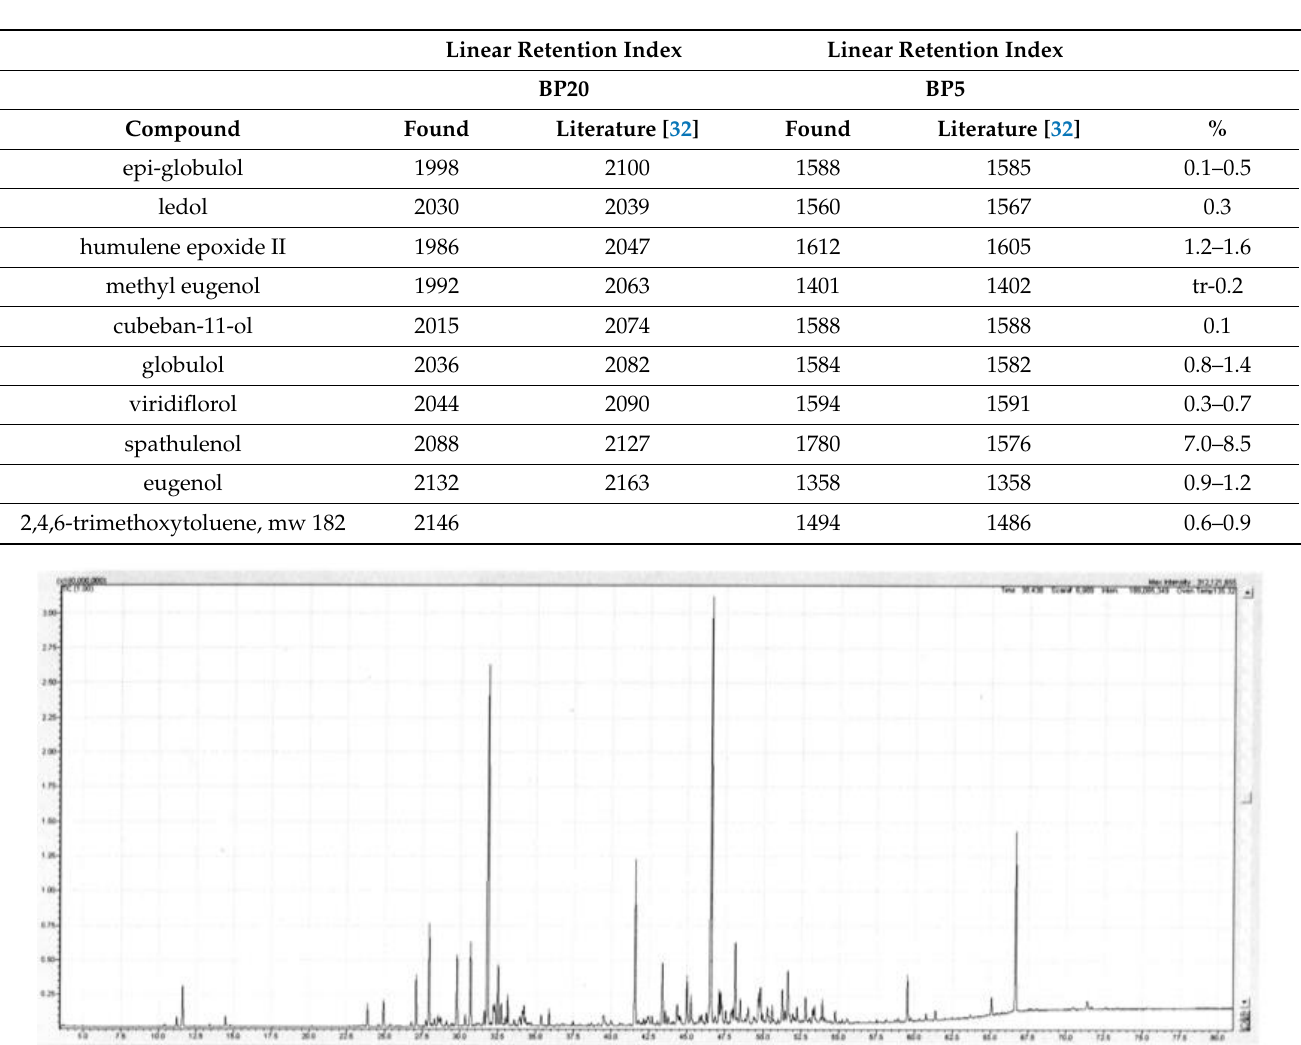
Figure 2. TIC trace on a polar column of the leaf oil of Backhousia tetraptera. Conditions are given in the Experimental section.